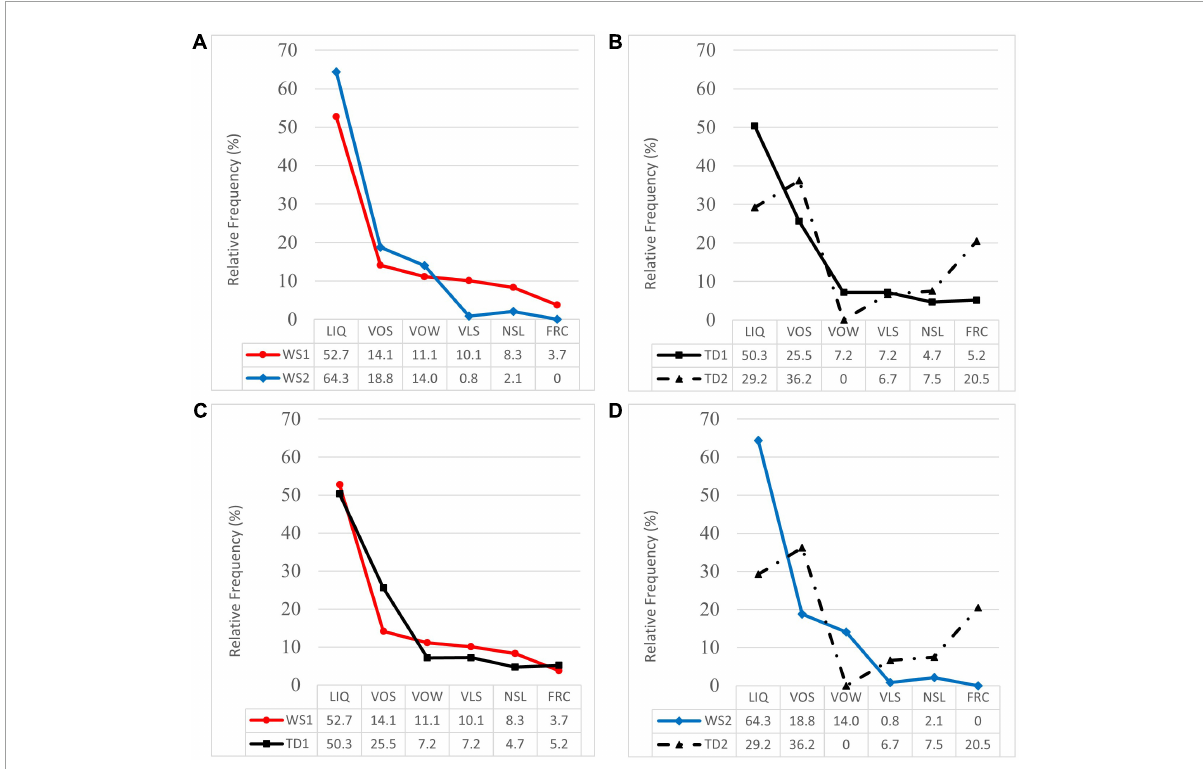
FIGURE4 Profiles of relative frequency of omission processes (LIQ, liquid; VOW, vowel; FRC, fricative; VOS, voiced stop; VLS, voiceless stop; NSL, nasal) for WS groups and TD groups. (A) Profiles of WS1 and WS2 groups. (B) Profiles of TD1 and TD2 groups. (C) Profiles of WS1 and TD1 groups. (D) Profiles of WS2 and TD2